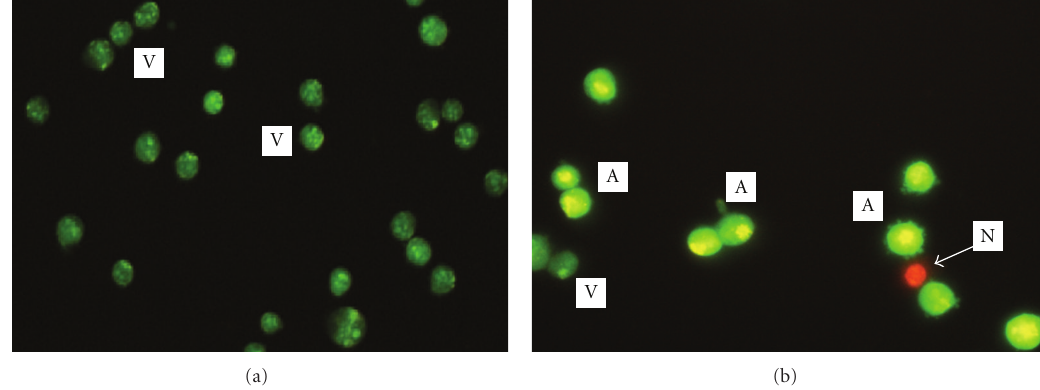
Figure 8: Morphology features of MCF7 cells incubated with pyranocycloartobiloxanthone A ( 1 ) were observed under fluorescence microscope (magnification 200x) (a) untreated MCF7cells (b) treated with pyranocycloartobiloxanthone A ( 1 ) at 5 μ g/mL (IC 50